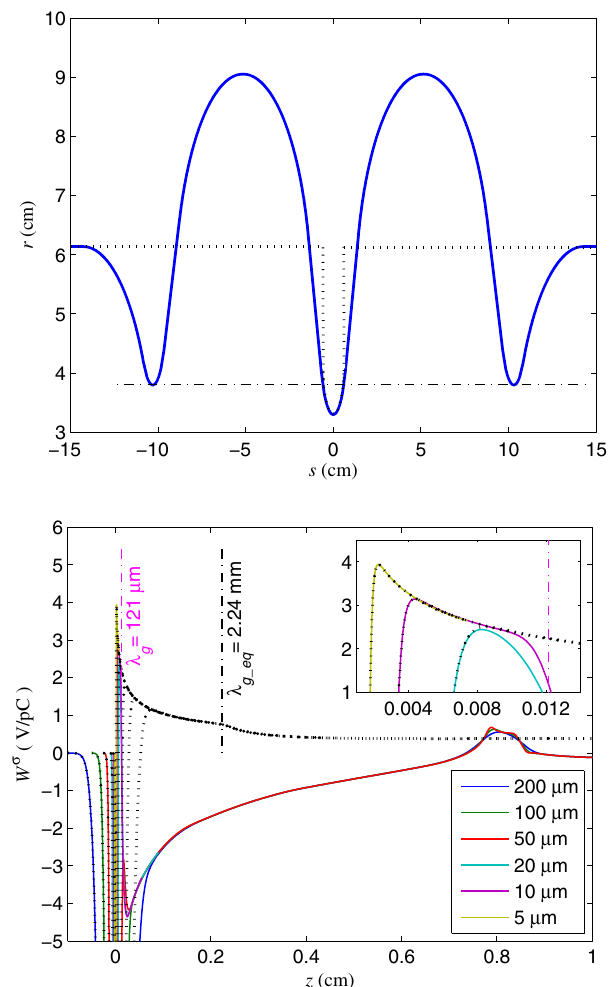
FIG. 12. (top) Harmonic cavity geometry (solid) and equiva- lent geometry (dots) for short-range wake calculations; (bottom) long-range wake potentials for the cavity (solid color) and equivalent (black dots)